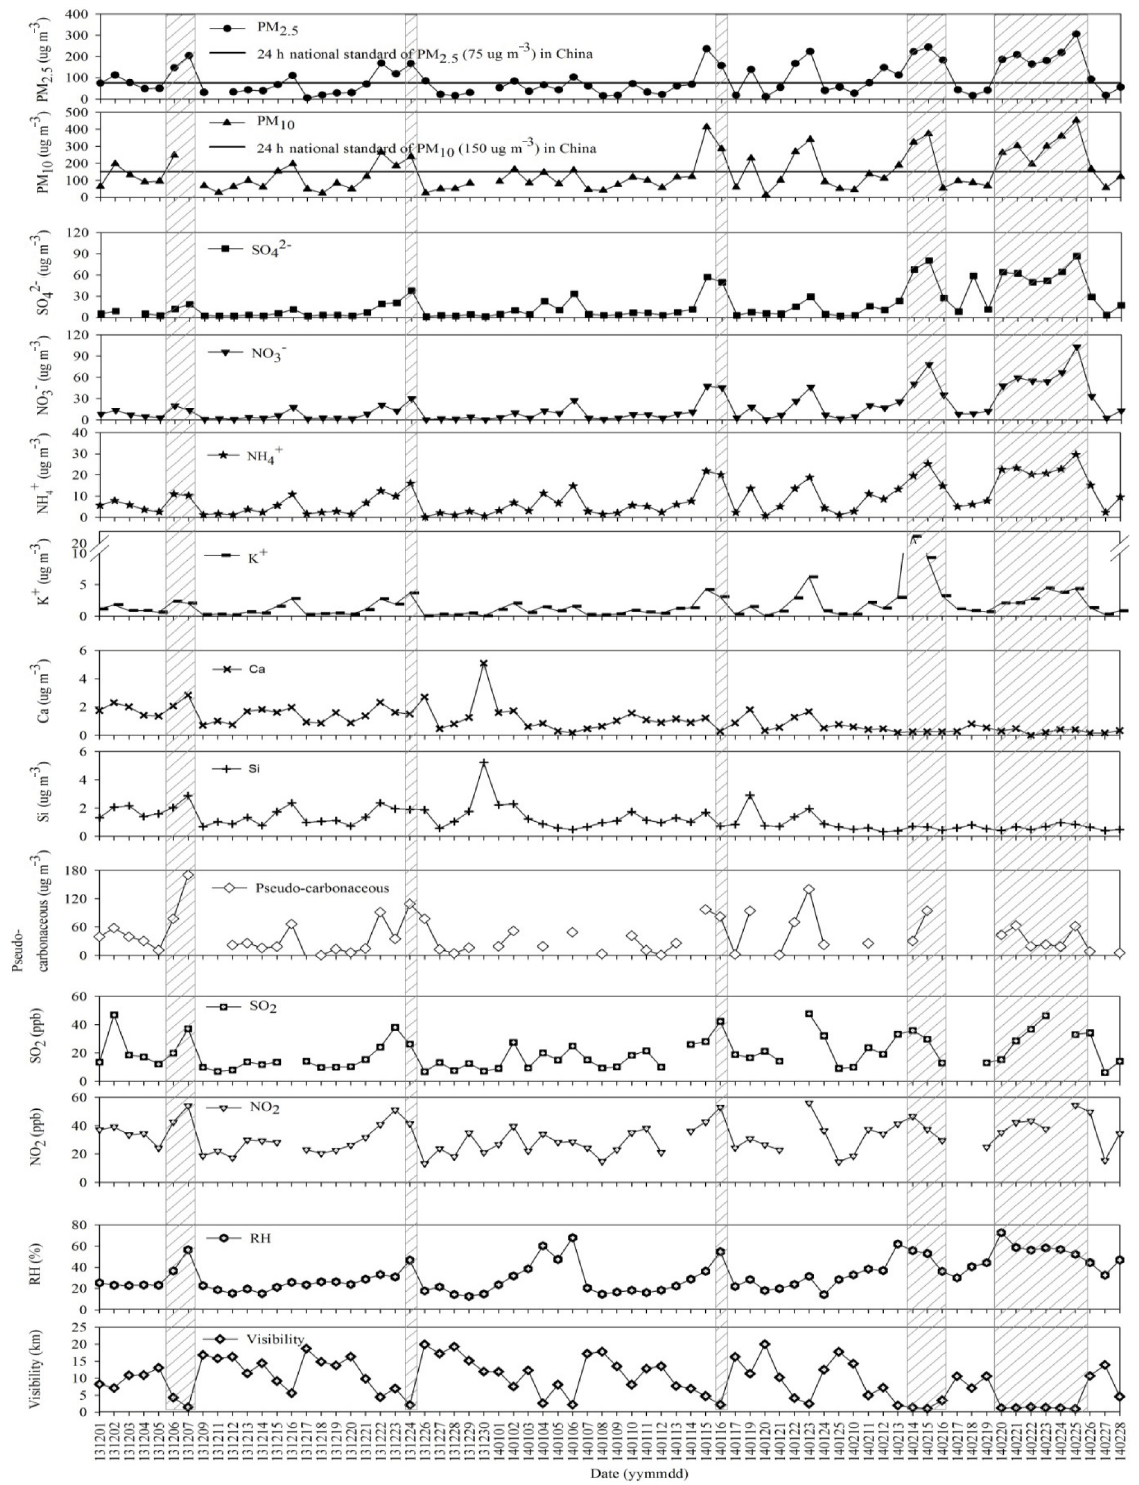
Figure 1. Variations in mass and chemical composition of PM 2 . 5 , PM 10 mass, gaseous precursors, and meteorological parameters measured from 1 December 2013 to 28 February 2014. Horizontal lines indicate the Chinese national standards of PM concentrations in 24h and the vertically shaded regions denote the 13 haze